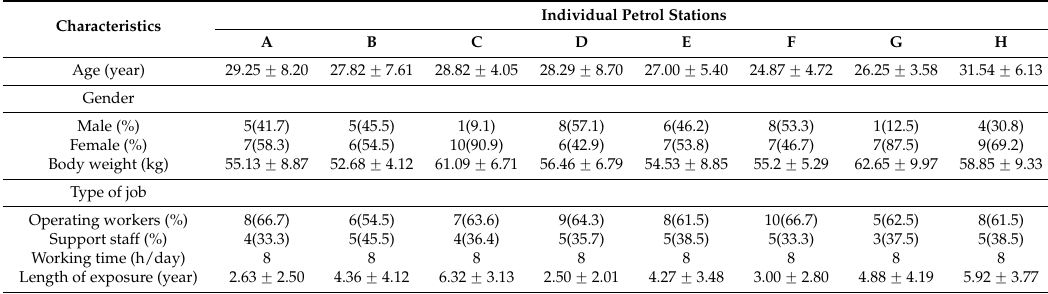
Table 2. Demographic characteristics of the study population